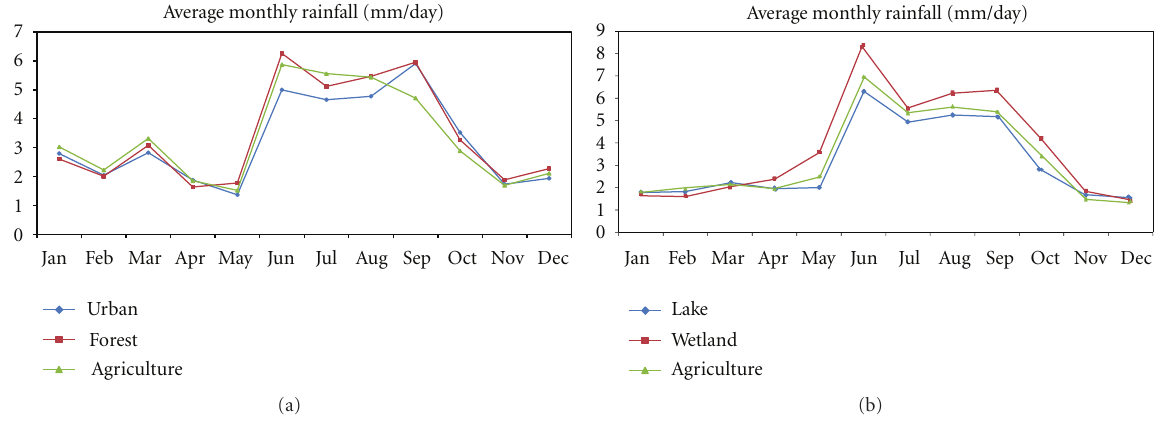
Figure 5: (a) The average monthly rainfall in Northeast Florida. (b) The average monthly rainfall in South Florida.